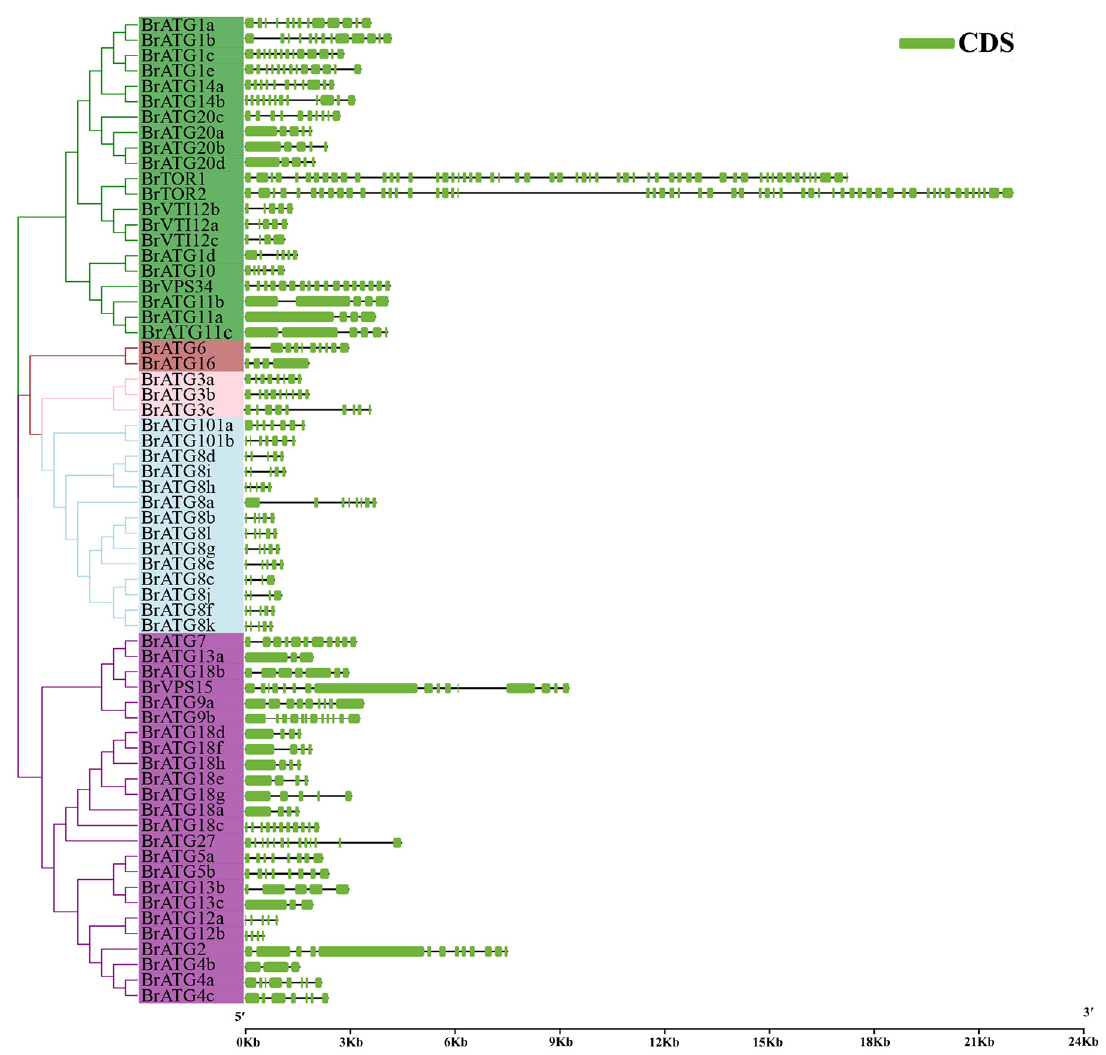
Figure 2. Gene structure analysis of BrATG gene in Chinese cabbage. Green boxes indicate exons, and black lines indicate introns.